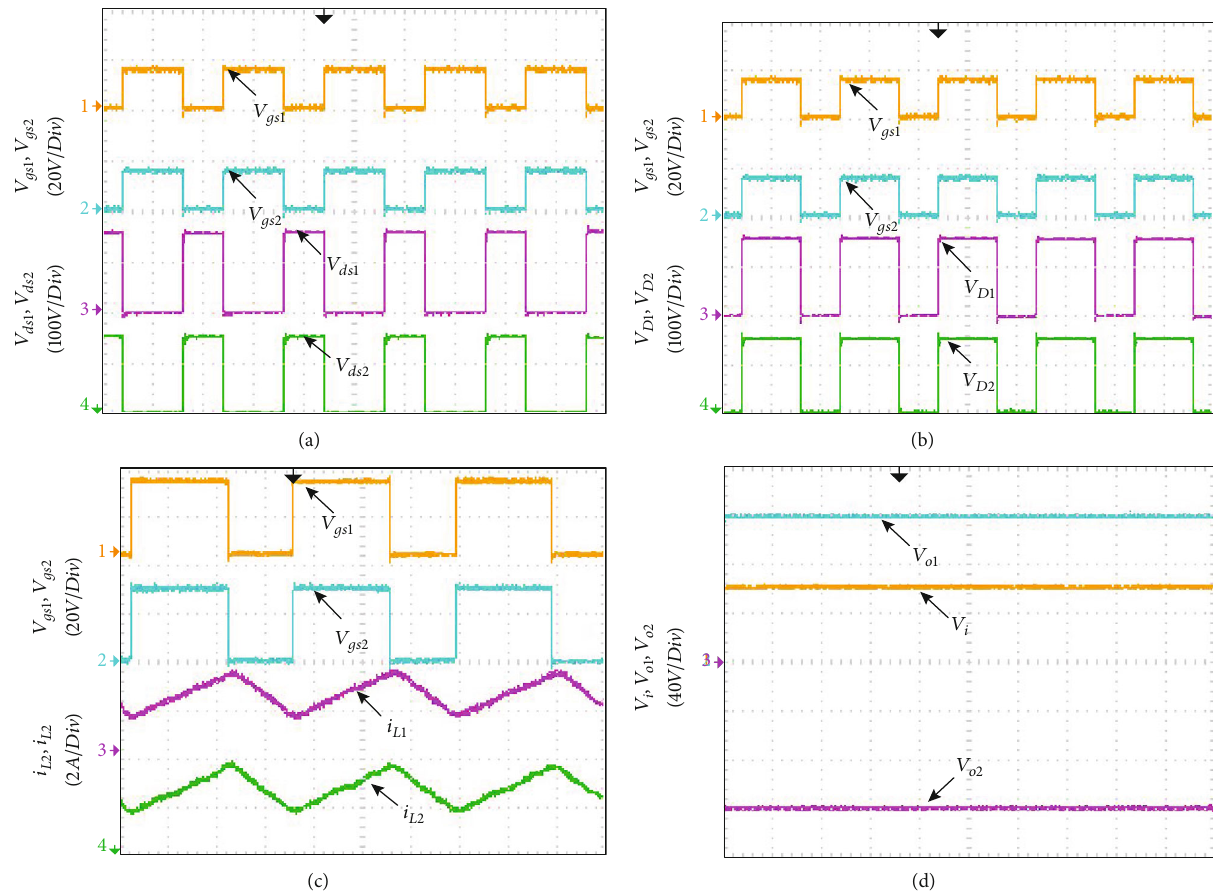
Figure 12: Experiment waveforms. (a) V